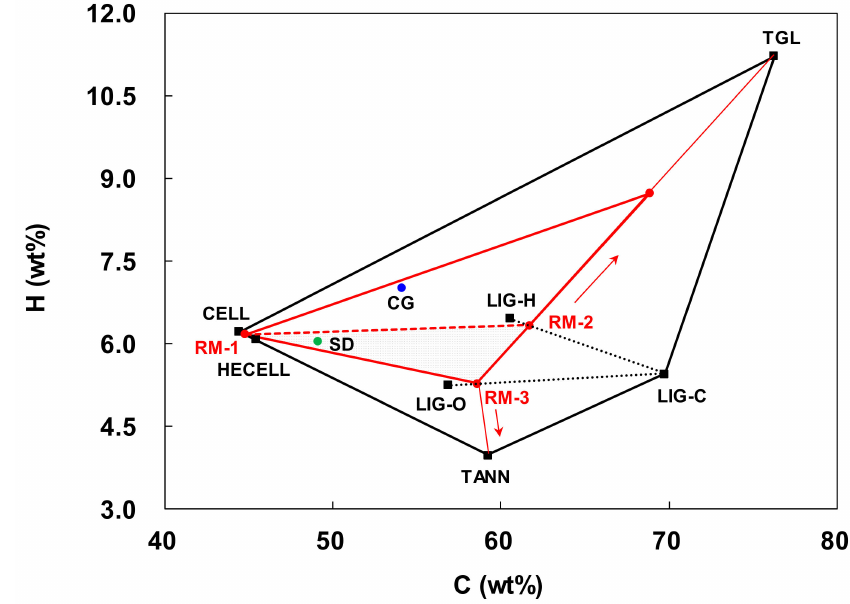
Figure 1. Biomass characterization from elemental